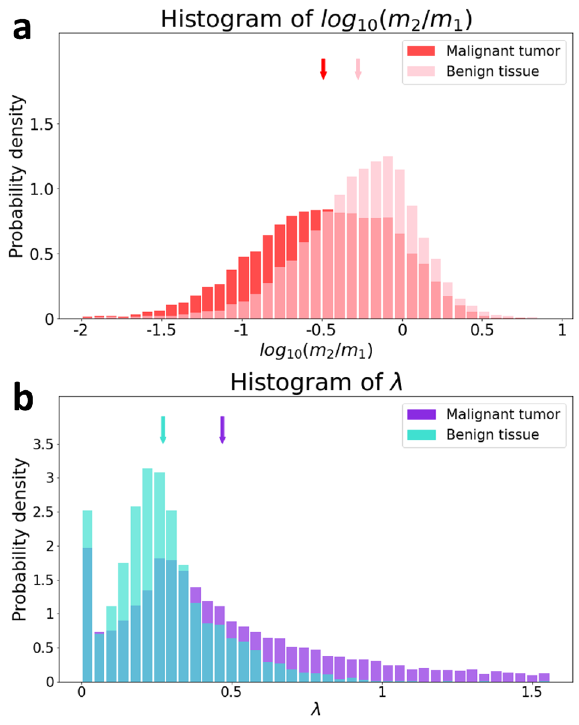
Figure 3. Histogram of parameters log 10 ( m 2 / m 1 ) and (cid:31) values between the tumor and tissue. ( a ) displays two histograms of log 10 ( m 2 / m 1 ) values collected from twelve tumor ROIs (total of ~ 12,900 pixels) and twelve reference tissue ROIs (total of ~ 8000 pixels) in six mice. ( b ) displays the corresponding two histograms for the (cid:31) values. The mean values of these parameters within the tumor ROIs and tissue ROIs are indicated by arrows of corresponding colors.